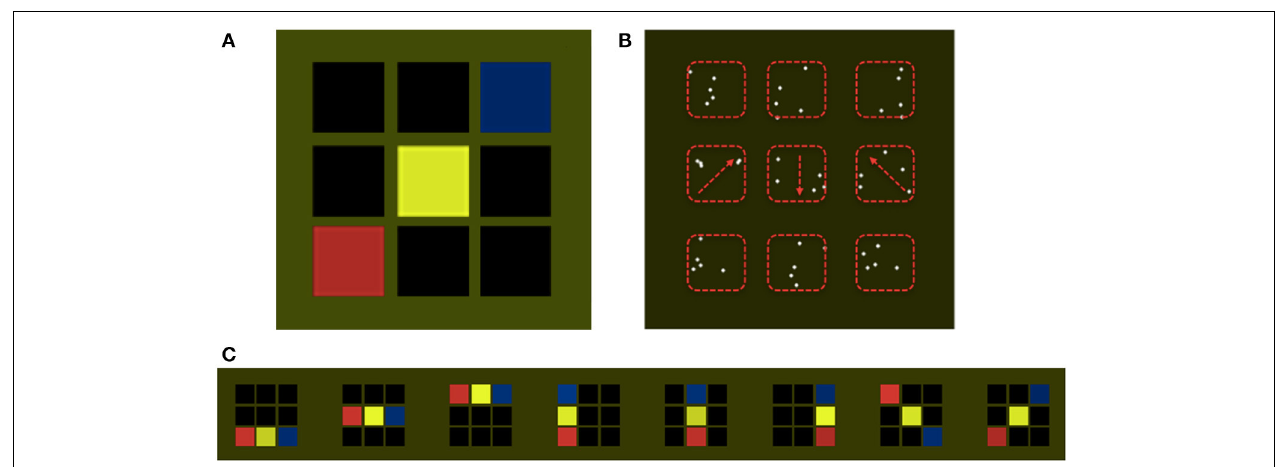
FIGURE 1 | Stimulus examples. Participants were trained to recognize patterns belonging to a target concept using visual displays consisting of specific sequences of color or directions of motion. Panel (A) shows an example of a target concept sequence, consisting of three colored squares embedded in a 3 × 3 grid. This example follows the concept rule, red precedes yellow precedes blue, from left to right (but in the actual experiment could also be bottom up, as shown in panel (C) . Panel (B) displays an equivalent example for the motion condition in which, each square is replaced by a set of white dots. Three sets of dots were moving (marked by the red arrows, not shown to observers), and all other sets of dots were stationary.